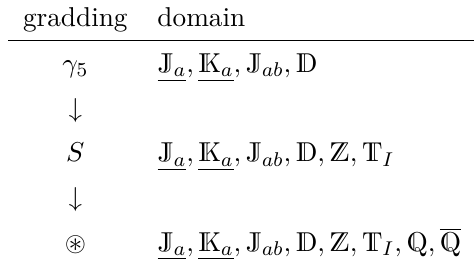
. This embedding 5